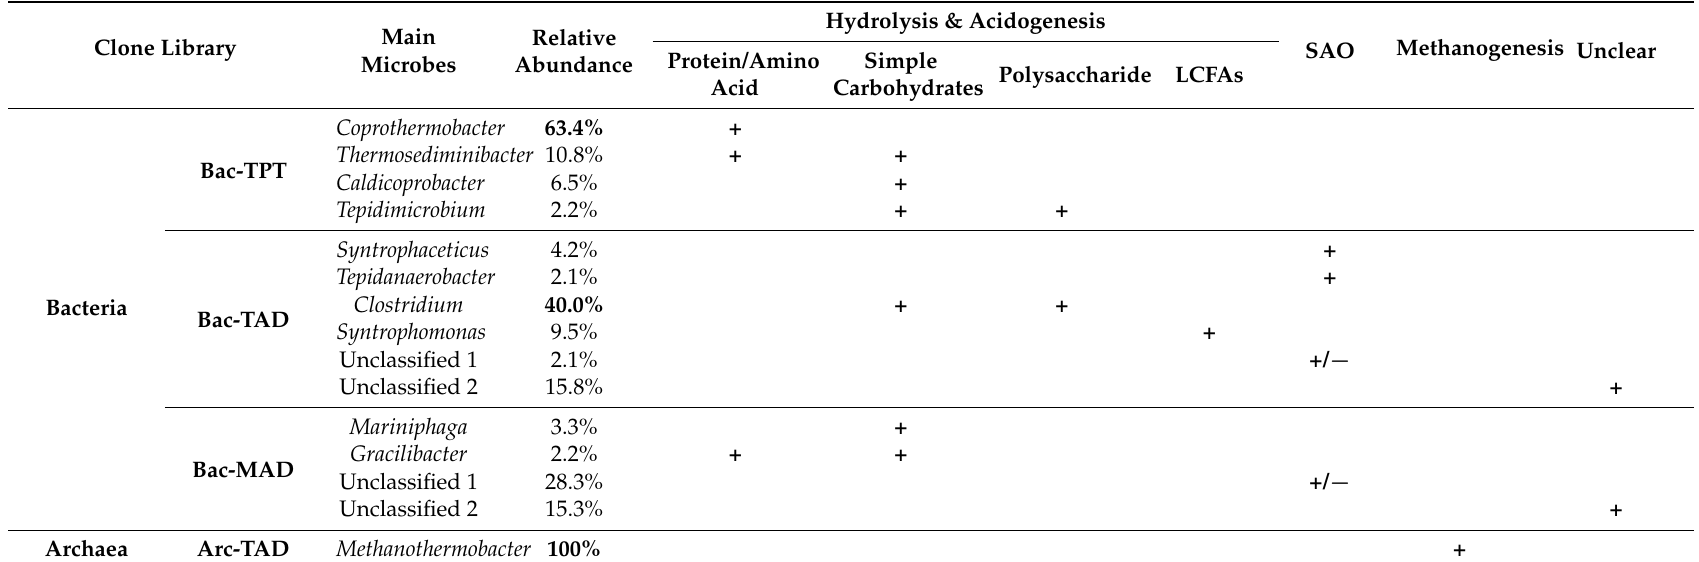
Table 4. Summary of the main microbial compositions in the HSAD